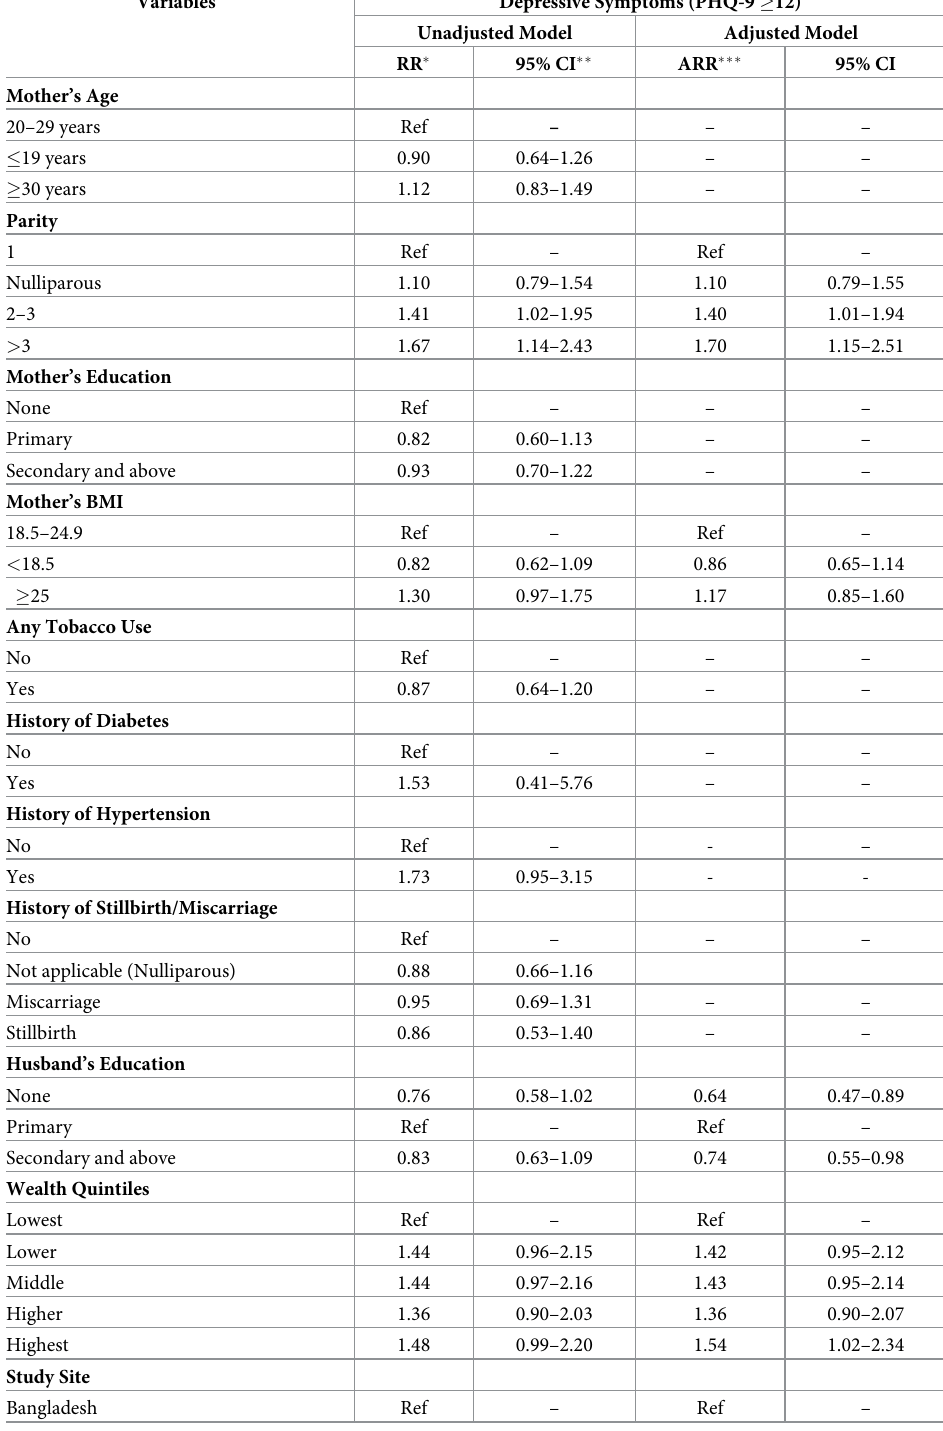
Table 2. Risk ratios for factors associated with maternal antenatal depressive symptoms (PHQ-9 �